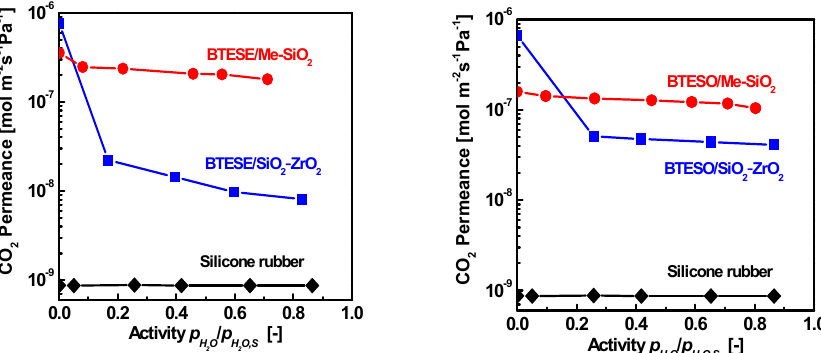
Figure 9. CO 2 permeance of organosilica membranes as a function of water vapor activity at 40 °C (Feed side: 500 mL/min, permeate side: 1000 mL/min). Reproduced from [104] .